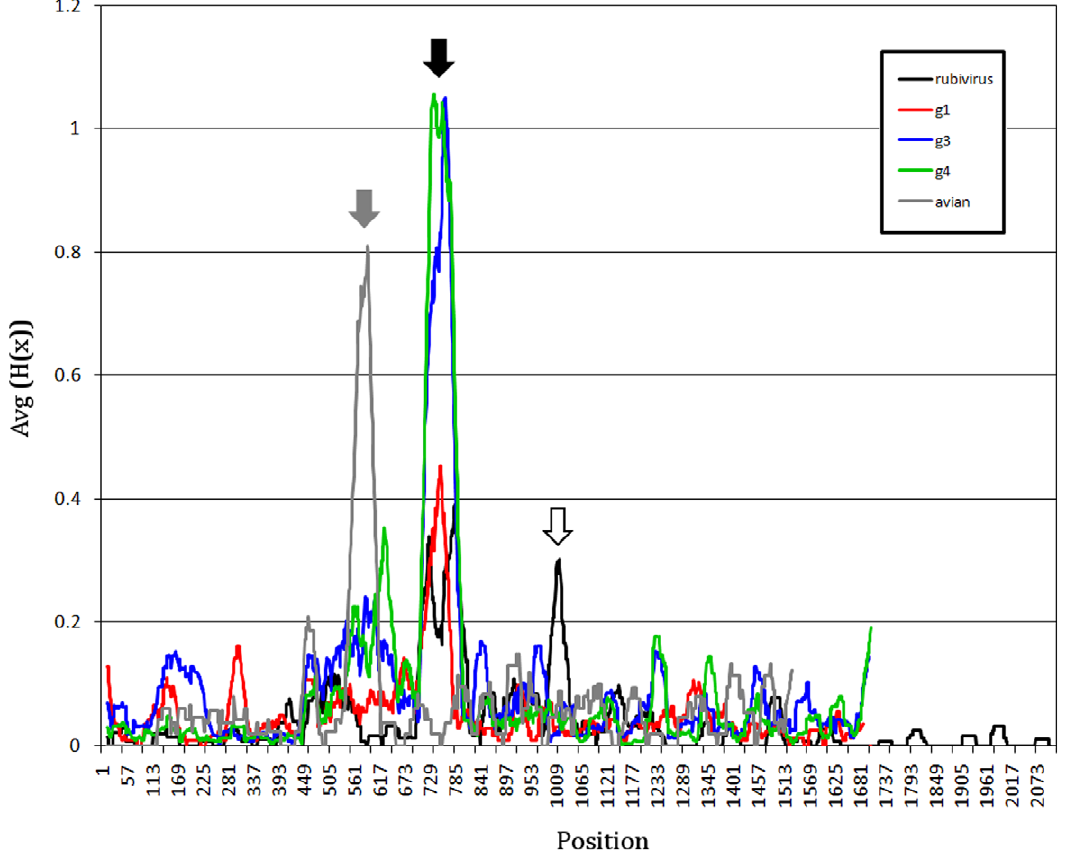
Figure 1. Shannon entropy for alignments of rubi-like viruses. Data are shown as the average Shannon entropy in 30-aa acid windows with a one-residue step. Sequences are full-length with the three ORFs concatenated in head-to-tail fashion as ORF1, ORF2 and ORF3. Rubi (rubivirus), DQ085338; g1 (genotype 1), M80581; g2 (genotype 2), M74506; g3 (genotype 3), AB369691; g4 (genotype 4), AB220972; avian, AY535004. Subtype 3f sequences have a 27-aa sequence duplication removed from the PPR to allow better alignment of sequences. The PPRs are located by the grey arrow (avian HEV) and the black arrow (rubivirus and HEV genotypes 1, 3 and 4). The white arrow is immediately upstream from the rubivirus endopeptidase (centered near residue 1010).